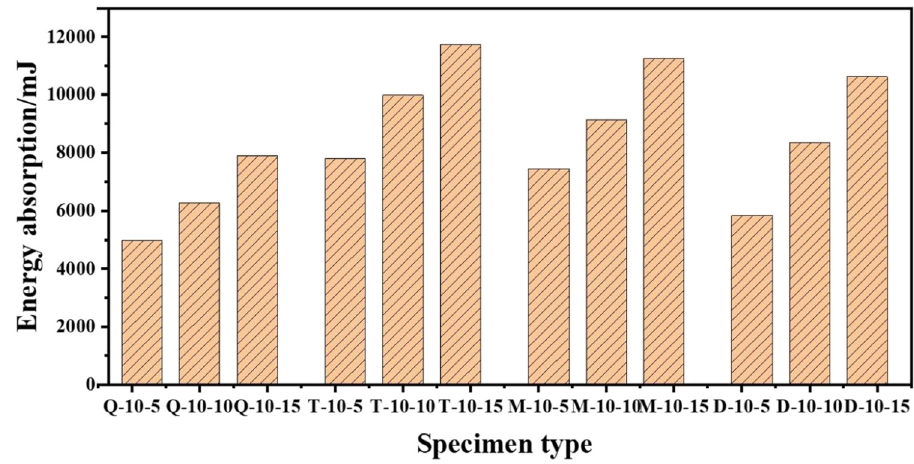
Figure 10: Energy absorption of di ff erent specimen